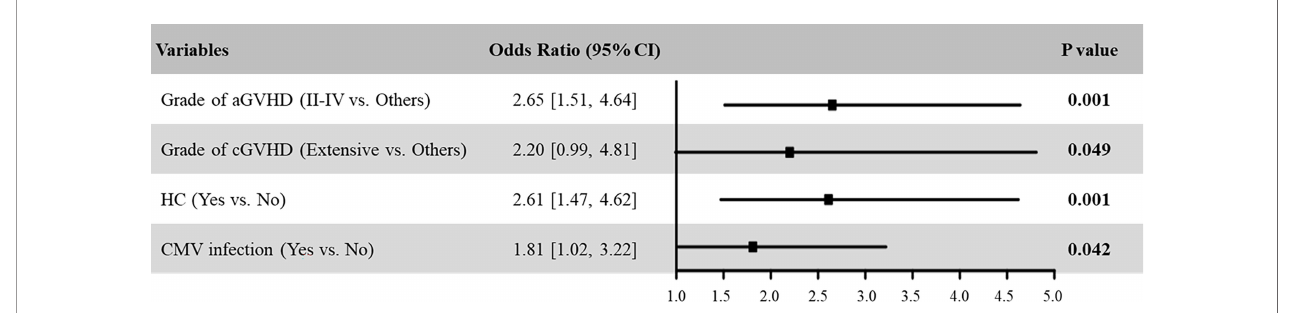
FIGURE 2 | Multivariable logistic regression model assessing risk factors for PT in MDS patients after